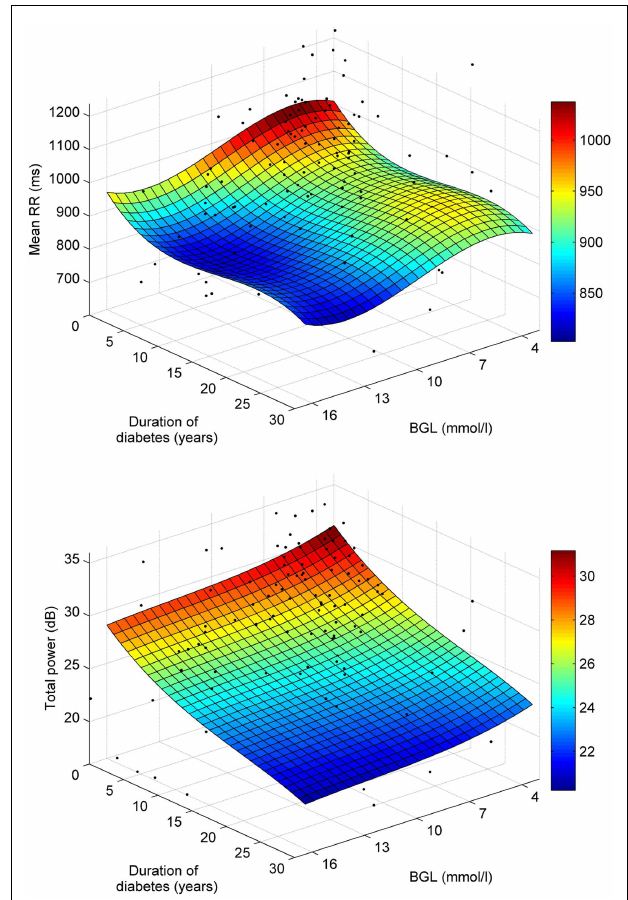
FIGURE 4 | Polynomial least squares surface fits for the associations of mean RR (top) and total power (bottom) with BGL and disease duration